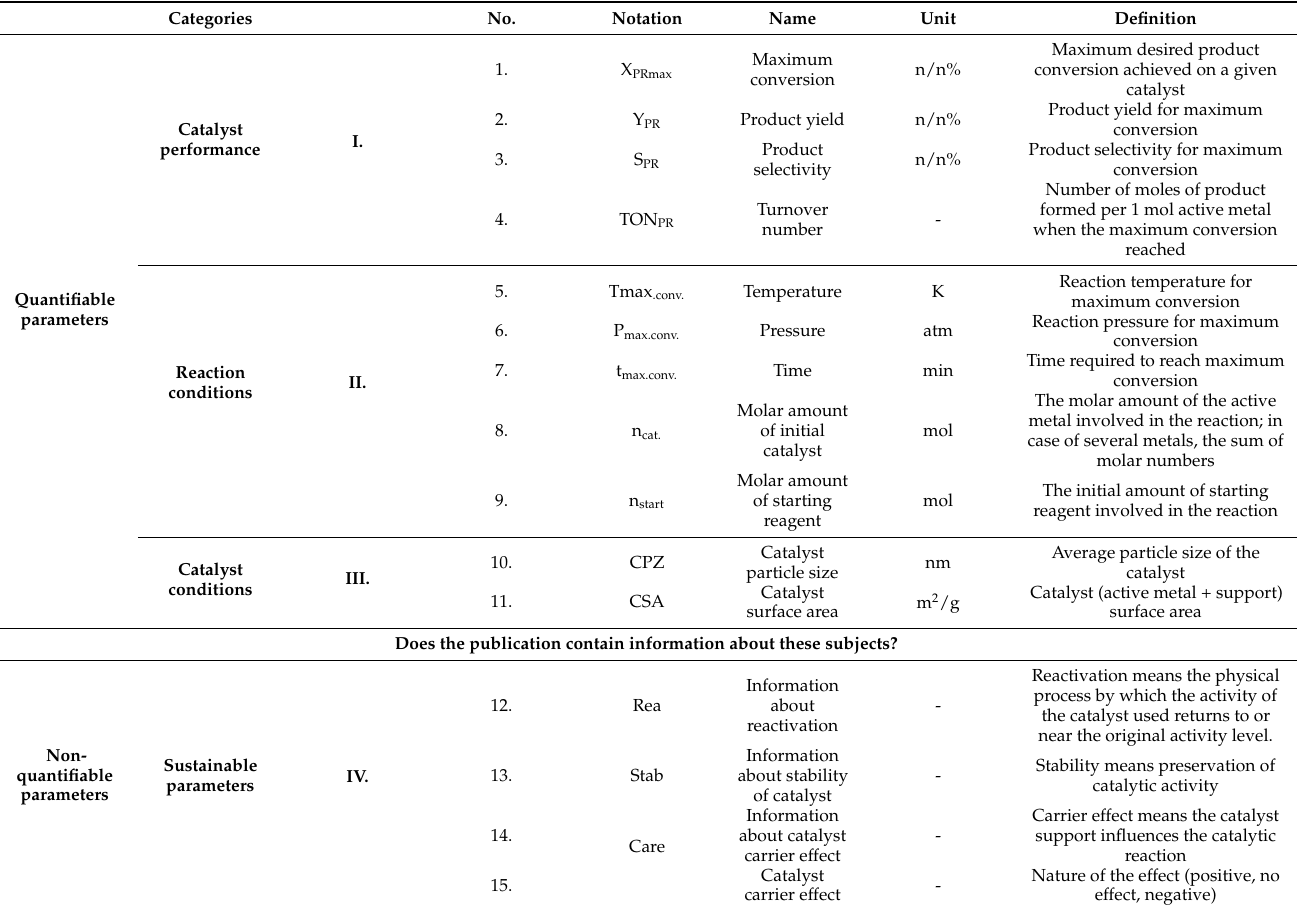
Table 2. Descriptor system of MIRA21 for TDA synthesis